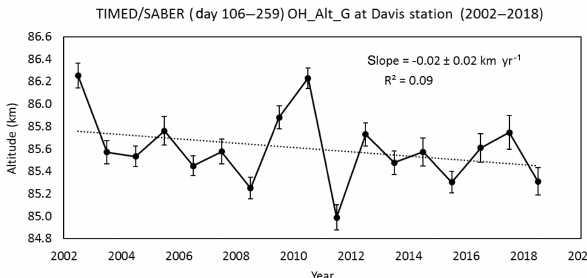
Figure 7. The trend in the mean winter OH layer altitude, derived from TIMED/SABER (version 2.0) OH-B channel volume emis- sion rate. The slope of the best-fit line is − 0 . 02 ± 0 . 02kmyr − 1 , i.e. no significant change in altitude of the layer over this